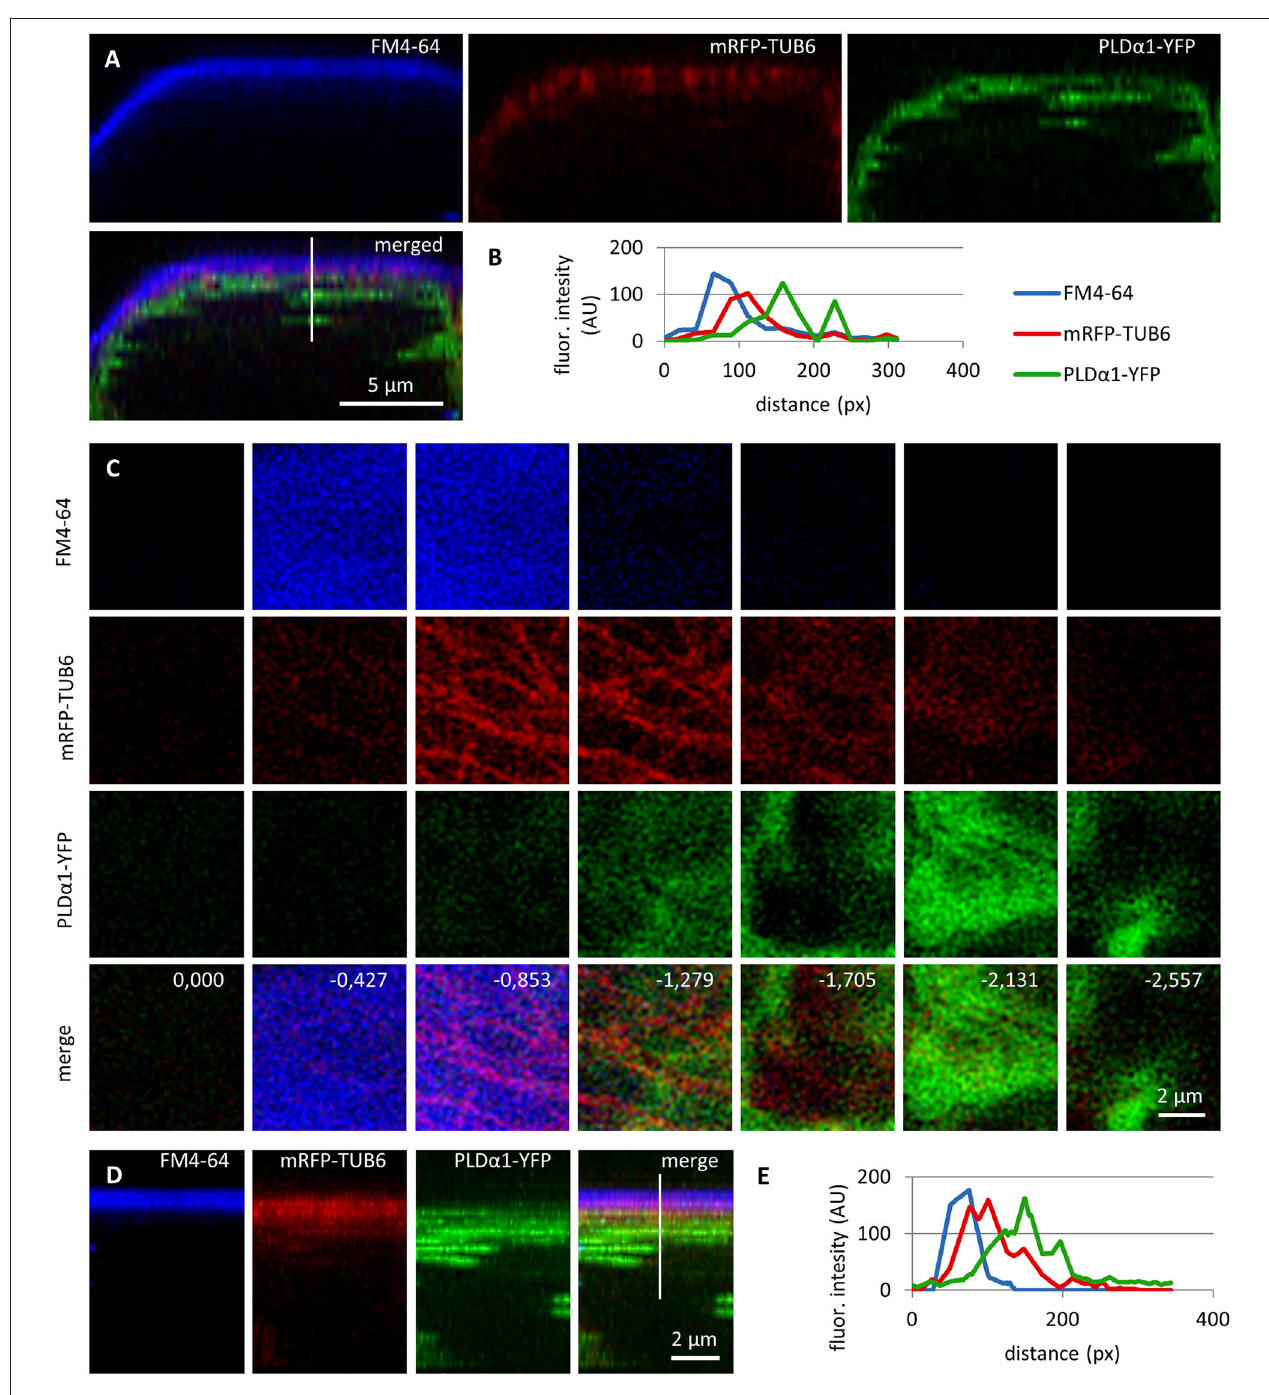
FIGURE 7 | Subcellular localization of PLD α 1-YFP and cortical microtubules in respect to the plasma membrane in leaf petiole epidermal cells of the pld α 1-2 mutant plants stably expressing PLD α 1-YFP driven by PLD α 1 own promoter. Living interphase petiole cells with the expression of PLD α 1-YFP (in green) and mRFP-TUB6 (in red) were counterstained with FM4-64 for delineation of the plasma membrane (in blue). (A) Orthogonal view of the 3D-reconstructed petiole cell from the z-stack imaging showing localization of plasma membrane, cortical microtubules and PLD α 1. Line in merged image indicates position of measured profile. (B) Profile intensity of fluorescence distribution of the plasma membrane (blue), cortical microtubules (red) and PLD α 1 (green) based on the distance from the cell surface. (C) Frontal view reconstructed from the individual z-stacks starting from the cell surface of the petiole cell to the cortical cytoplasm in steps indicating thickness of individual optical sections in µ m. Individual channels are shown separately for the plasma membrane (labeled in blue), cortical microtubules (labeled in red) and PLD α 1 (labeled in green), while the merge image shows the overlay of all three channels with the depth annotation. (D) Maximum intensity projection of the same image as in C from the side view (orthogonal projection) with the line indicating position of measured profile. (E) Profile intensity of fluorescence distribution of the plasma membrane (blue), cortical microtubules (red) and PLD α 1 (green) from (D) based on the distance from the cell surface. Analysis made in confocal microscope.